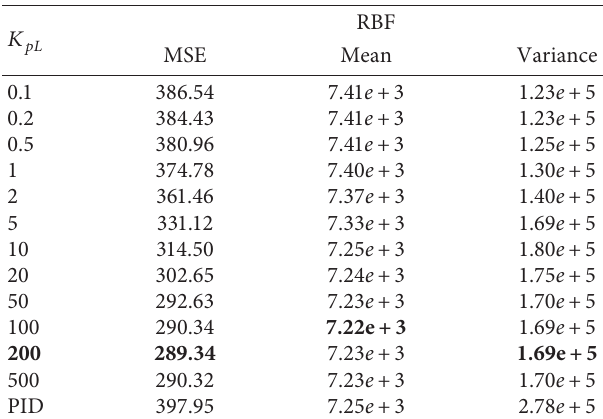
Table 7: Variation of MSE output power mean and variance with K pL .